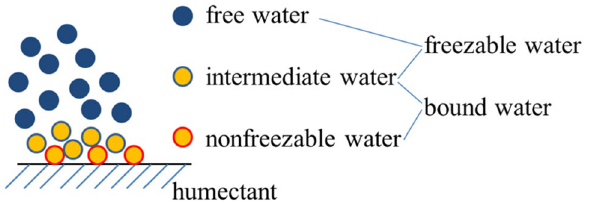
Figure 1. Three hydrated water types in a